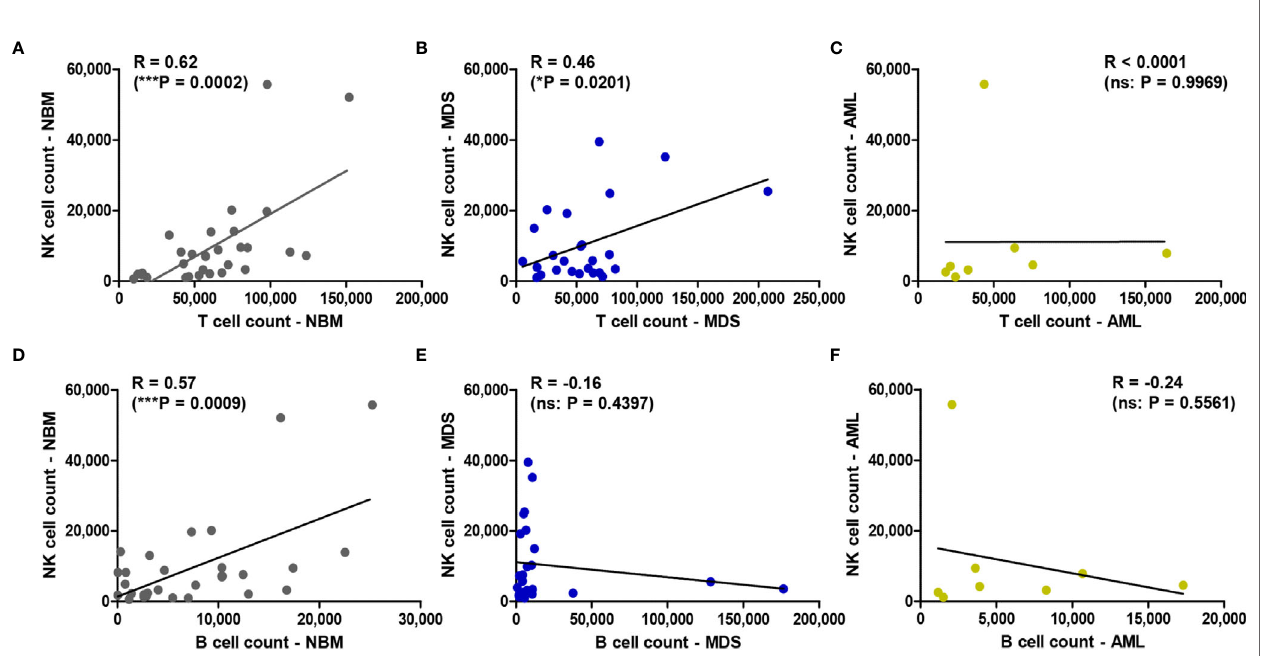
FIGURE 2 | Regression statistics describing the relationship between bone marrow NK, T, and B cell counts for the three case groups: NBM, MDS, and AML. Correlation coef fi cients (R) were computed for (A) NK and T cell counts in NBM cases (n = 30); (B) NK and T cell counts in MDS (n = 25); (C) NK and T cell counts in AML (n = 8); (D) NK and B cell counts in NBM cases (n = 30); (E) NK and B cell counts in MDS (n = 25); (F) NK and B cell counts in AML (n = 8). Data are presented as scatter plots. Spearman test was used to analyze the signi fi cance of the identi fi ed correlations (***P < 0.001, *P < 0.05, ns, not signi fi cant).